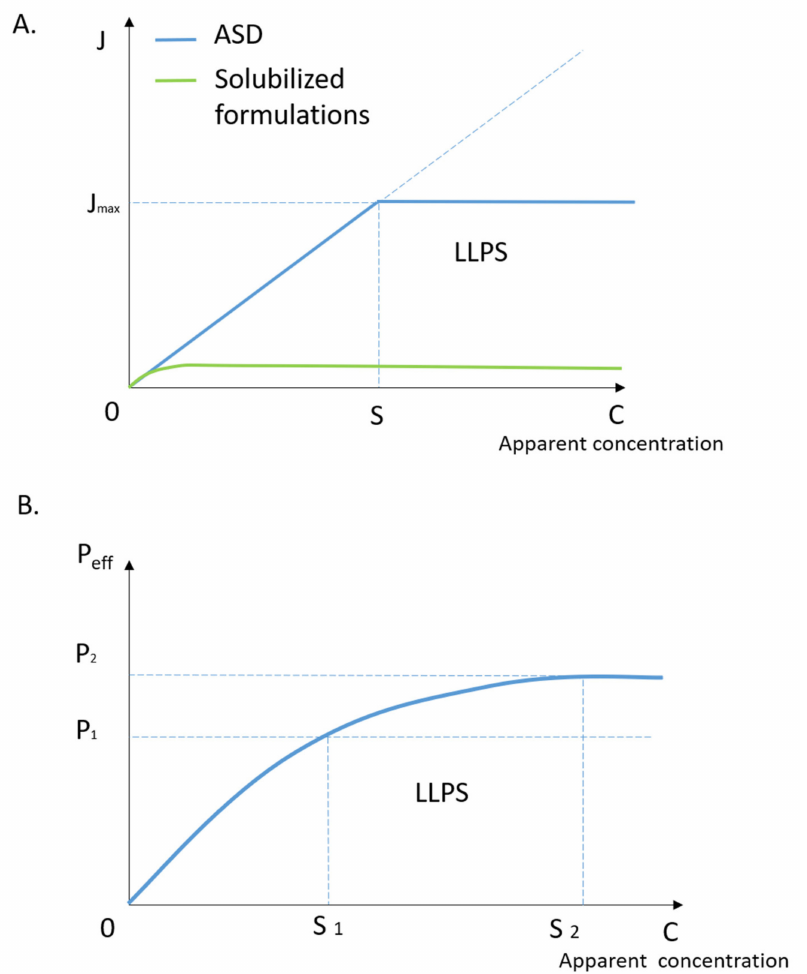
Figure 4. ( A ) Schematic diagram of the drug flux across the membrane as a function of apparent concentration. The blue line represents the theoretical drug flux across the membrane for ASD and the green line represents that of solubilizing formulations, S represents the concentration where the drug-rich phase forms. ( B ) The schematic diagram of permeability with the increasing of apparent concentration in the donor compartment with considering the effect of the drug-rich phase on the effective thickness of ABL. S1 represents the concentration at which the drug-rich phase forms, S2 represents the maximum effective concentration for the drug-rich phase in respect to the permeability